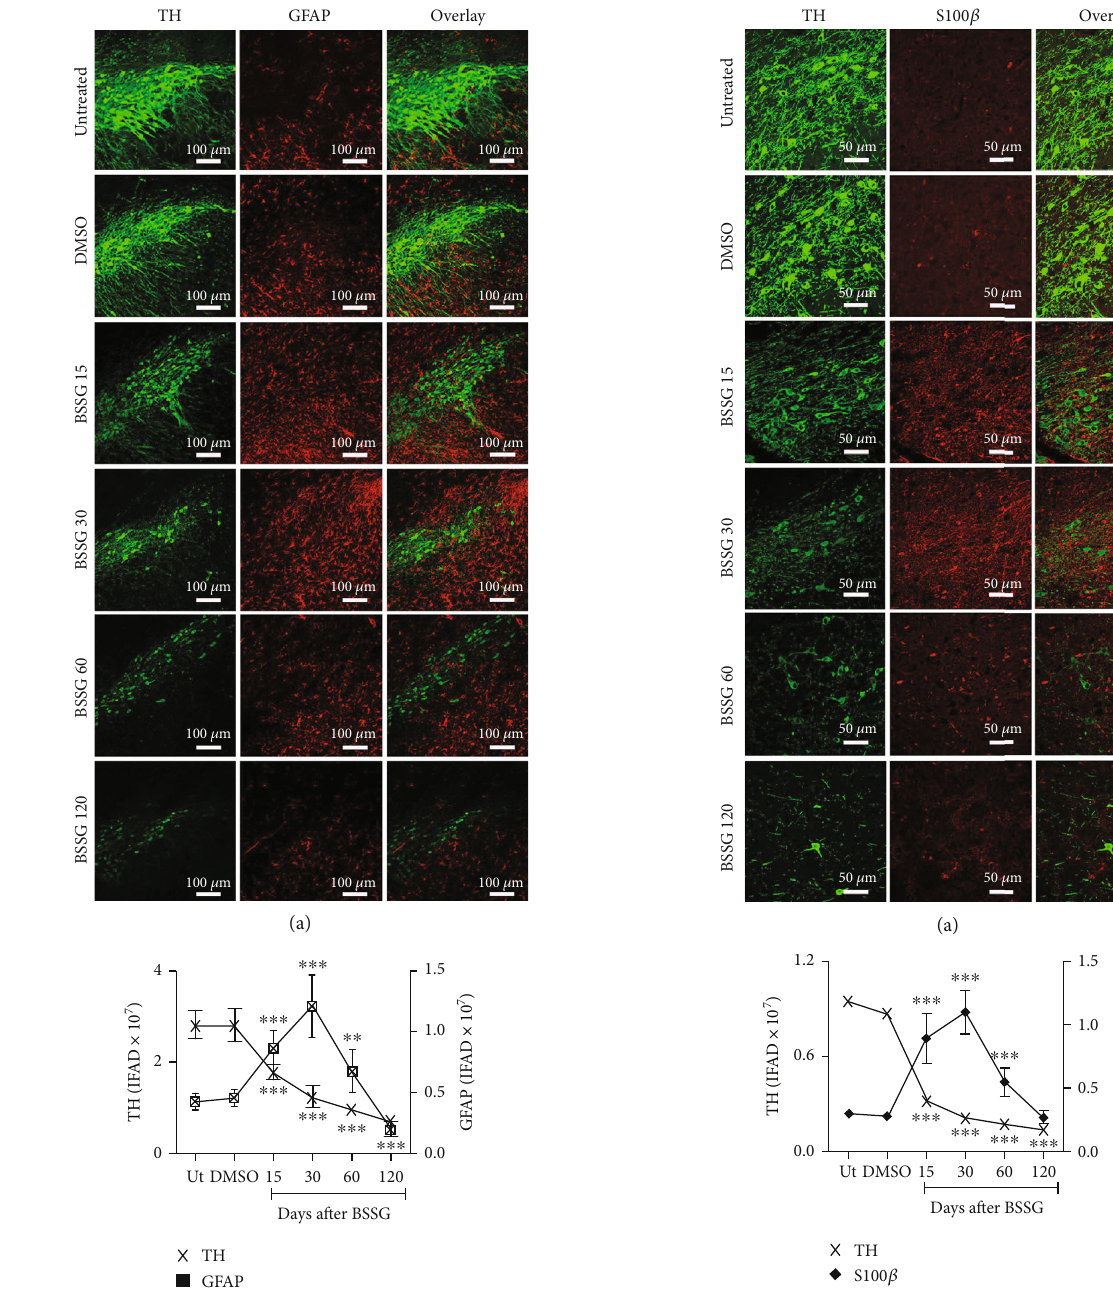
Figure 4: Time course of the astrocytic reactivity marker GFAP after a BSSG injection in the SNpc. (a) Representative micrographs of double immuno fl uorescence of TH and GFAP in untreated (Ut) control rats and rats at di ff erent times (shown at the left side of micrographs) after BSSG injection. (b) IFAD quanti fi cation for TH and GFAP during the experimental time course. The values are the mean ± SD from four anatomical levels. n = 3 independent rats in each time of each experimental condition. Two-way ANOVA and post hoc Bonferroni tests were applied for statistical analysis. The levels of signi fi cance were ( ∗ ) P < 0 : 05 , ( ∗∗ ) P < 0 : 01 , and ( ∗∗∗ ) P < 0 : 001 compared with the DMSO mock and Ut groups of the respective immunostaining.